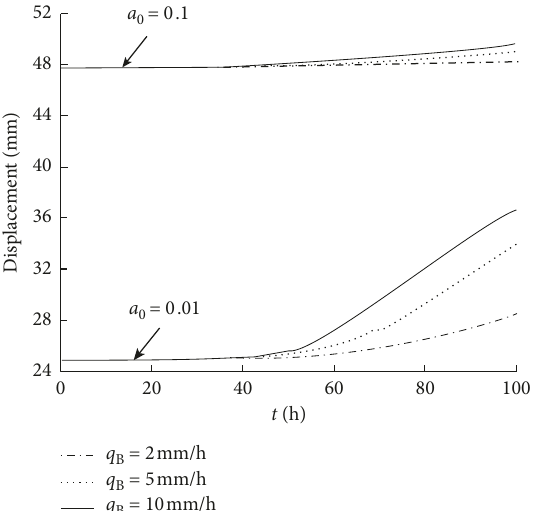
0.0. (b) b 1.0. (cid:31) (cid:31)